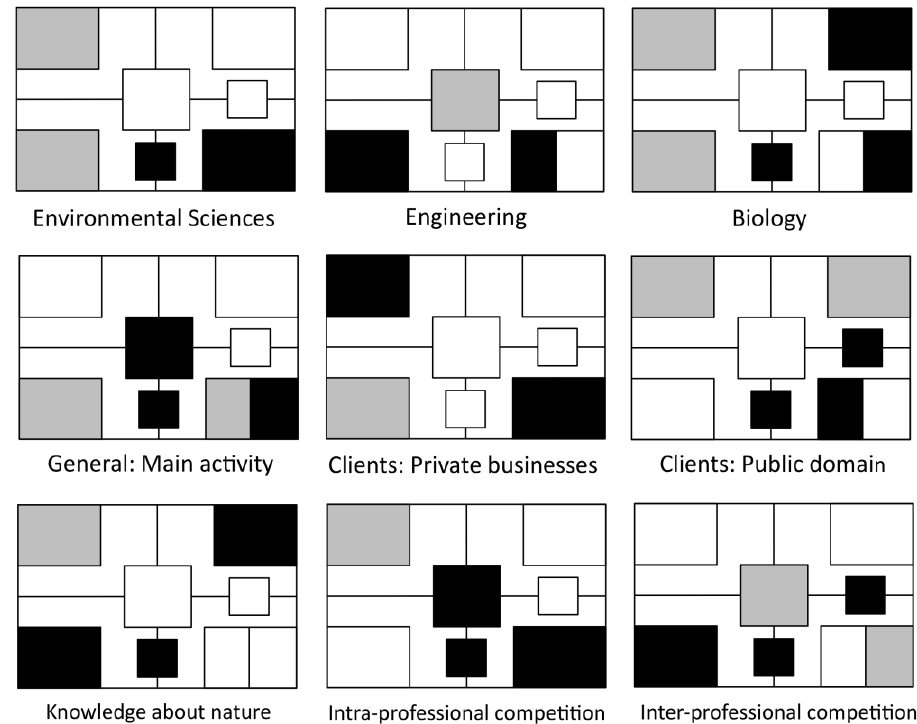
Figure 2. Applications of the 1997 model of the field of environmental tasks (see Fig. 1). Black fields: ranking first or highest; white fields: ranking last or lowest; grey: medium results. Analyses of variances (df = 7), differences are statistically significant (p < .05). cf. Mieg